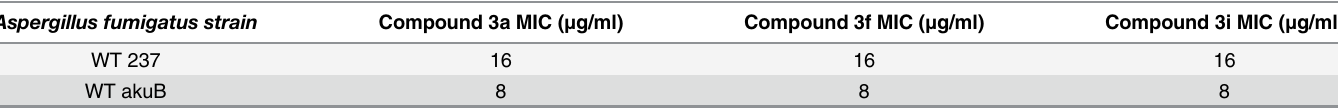
Table 3. MIC values obtained from the lead AIT compounds against A . fumigates , which expresses CYP51. Given the activity of compounds in this system this finding corroborates CYP51 as a plausible target of the AIT series. Aspergillus fumigatus